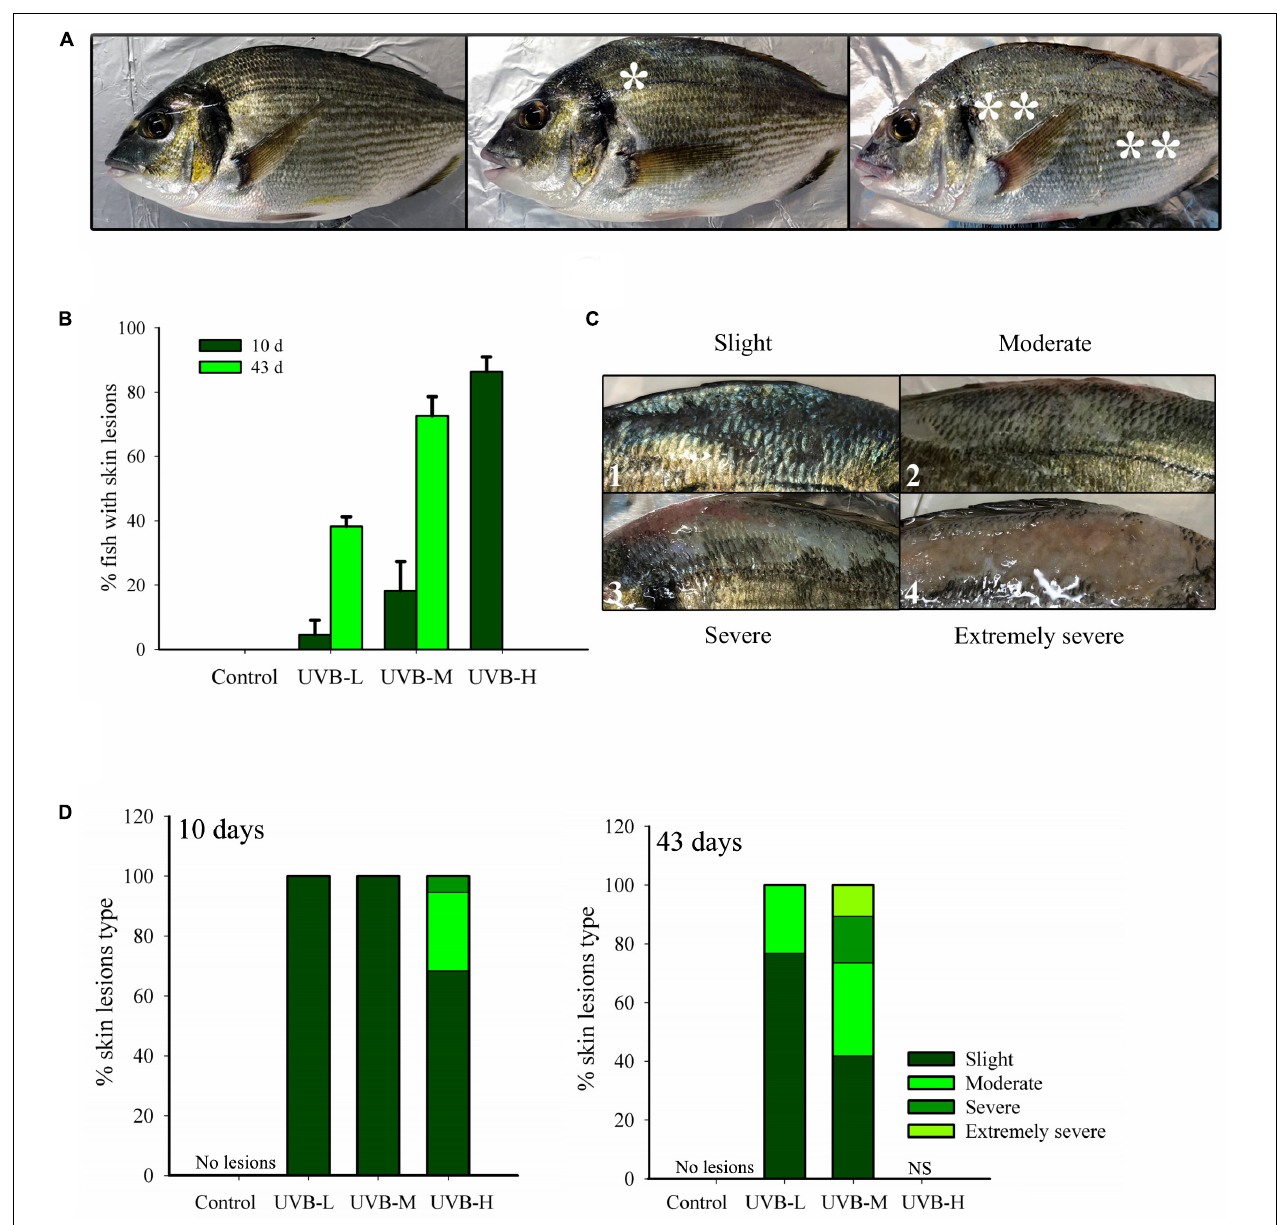
FIGURE 3 | Superficial skin lesions (sunburn) on S. aurata after 10 and 43 days exposure to UVB. (A) Lesions location. *Lesions located only below the dorsal fin; ** lesions located on the whole body of the fish; (B) % of juveniles showing skin lesions (10 days of exposure: n = 30, 43 days of exposure: control, n = 30; UVB-L, n = 30; UVB-M, n = 28; mean ± SD); (C) Different types of skin lesions: 1 – slight, 2 – moderate, 3 – severe, 4 – extremely severe; (D) % of each type of skin lesion identified in the 10 days ( n = 30) and 43 days (control, n = 30; UVB-L, n = 30; UVB-M, n = 28) UVB exposed